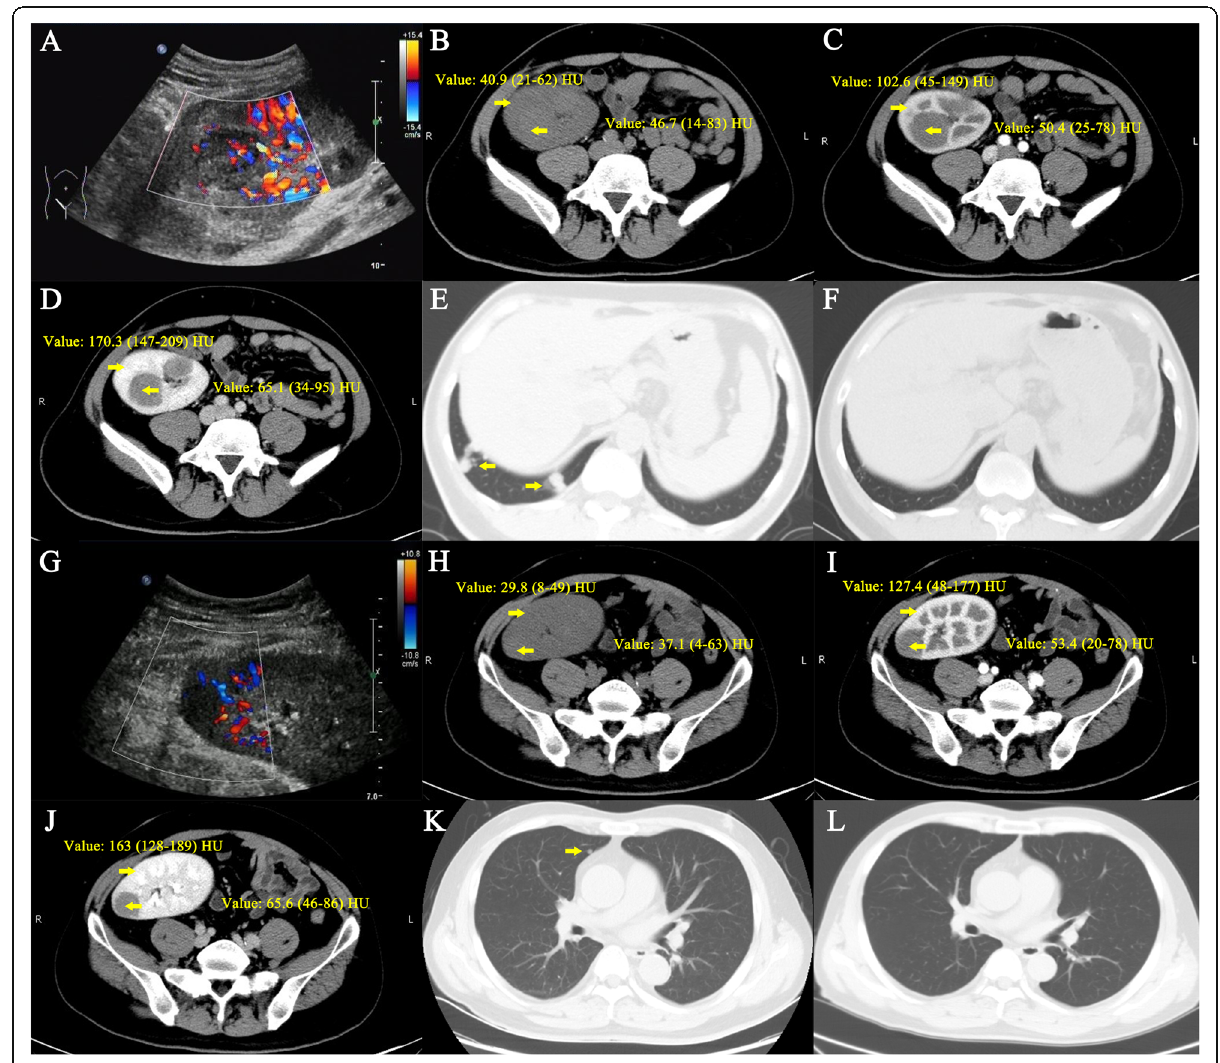
Fig. 2 US and CT manifestations. Images A – F and G – L are from recipients 2 and 3, respectively. A and G : Color Doppler flow images revealed solid hypo-echo neoplasm with punctiform blood flow signals in the transplanted kidneys. B and H : Non-enhancing CT revealed slightly higher densities of neoplasms than allografts. C , D , I , J : Enhanced multiphase images revealed slow and relatively homogeneous enhancement inside the neoplasms, with lower densities than the allografts. E and K : CT revealed pulmonary metastases. F and L : CT revealed elimination